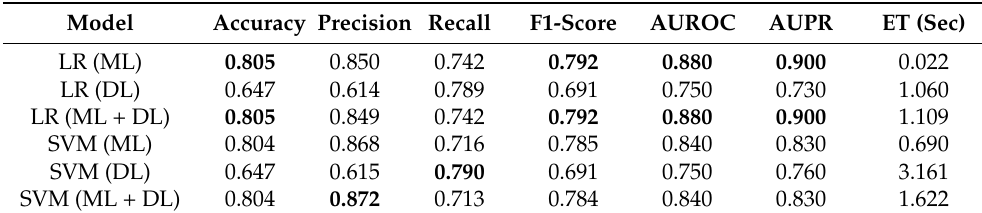
Table 3. Performance values of the stacking ensemble models.